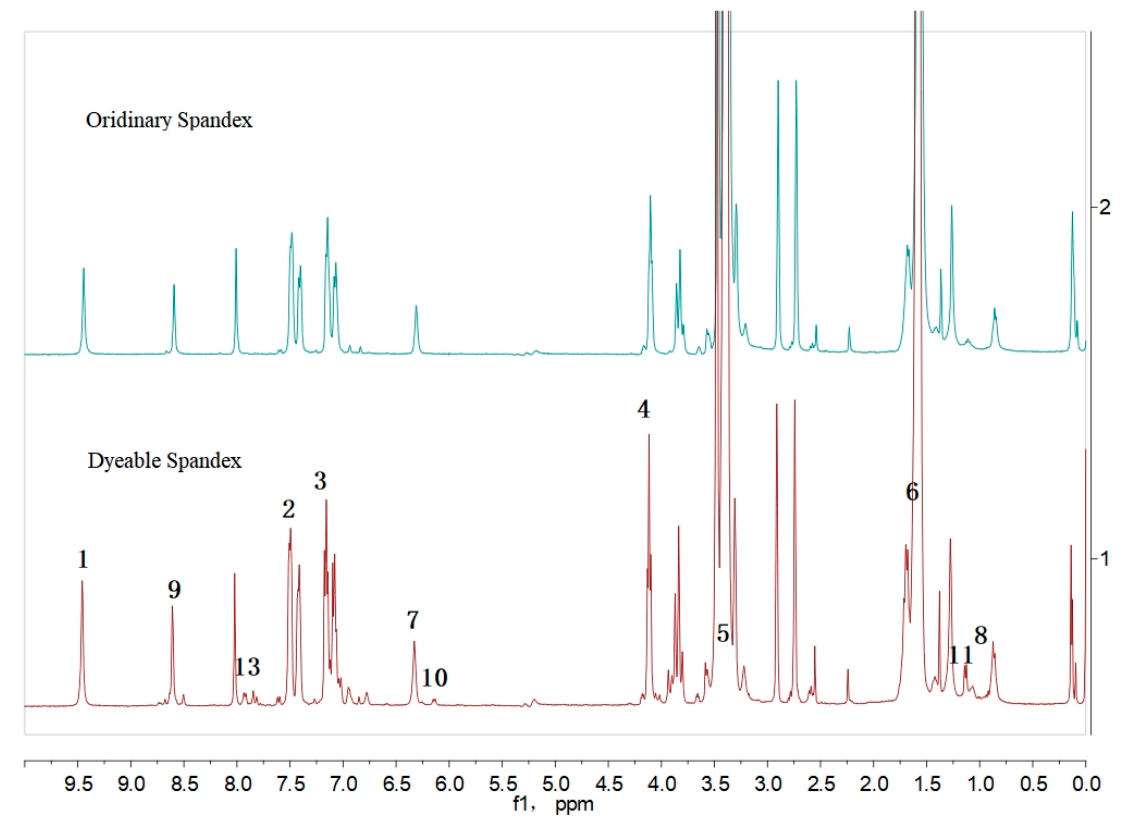
Figure 6. 1 H NMR spectrum of spandex fiber.